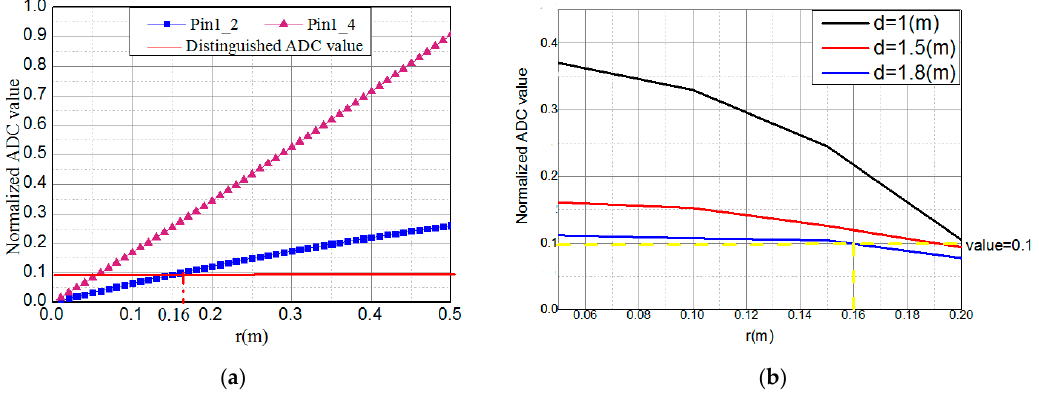
Figure 5. The difference of the ADC value of two adjacent PINs ( a ) at different radius of the PIN circle; ( b ) at different distance.